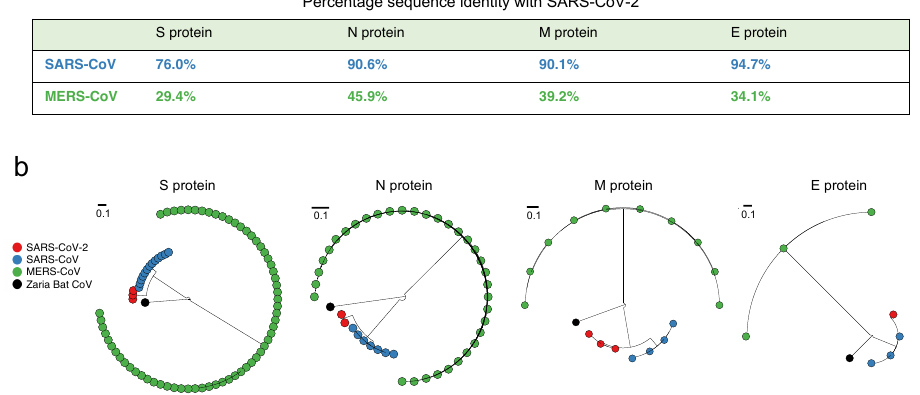
Figure 1. Comparison of the similarity of structural proteins of SARS-CoV-2 with the corresponding proteins of SARS-CoV and MERS (Middle East Respiratory Syndrome)-CoV. ( a ) Percentage genetic similarity of the individual structural proteins of SARS-CoV-2 with those of SARS-CoV and MERS-CoV. Thereferencesequenceofeachcoronavirus(MaterialsandMethods)wasusedtocalculatethepercentage genetic similarity. ( b ) Circular phylogram of the phylogenetic trees of the four structural proteins. All trees were constructed based on the available unique sequences using PASTA [31] and rooted with the outgroup Zaria Bat CoV strain (accession ID: